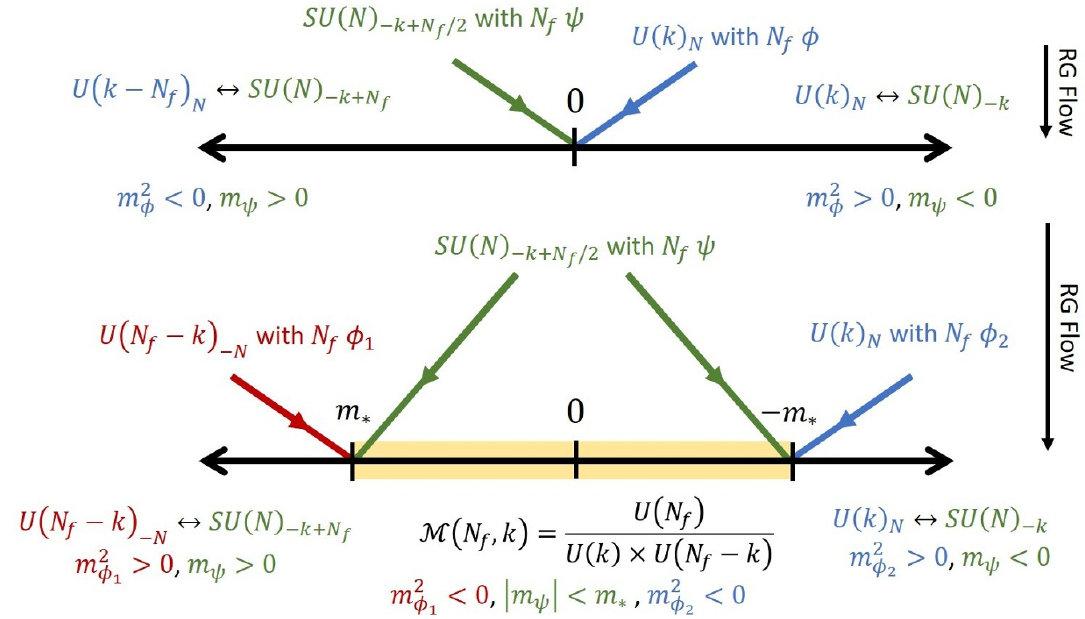
Figure 1. Top: mass deformation diagrams of the (cid:13)avor-bounded 3d bosonization dualities of (1.1a) where N f (cid:20) k . Here the blue and green lines are the RG (cid:13)ows of the respectively theories, and the black line is the mass deformation axis. Bottom: the (cid:13)avor-violated extension of the usual 3d bosonization dualities proposed by [25]. Here we are working in the regime where k < N f < N (cid:3) and N > 2. The portion of the axis which is shaded yellow is the Grassmannian phase. The SU levels are without the additional (cid:0) N f = 2 shift ref. [25] (and many others) use